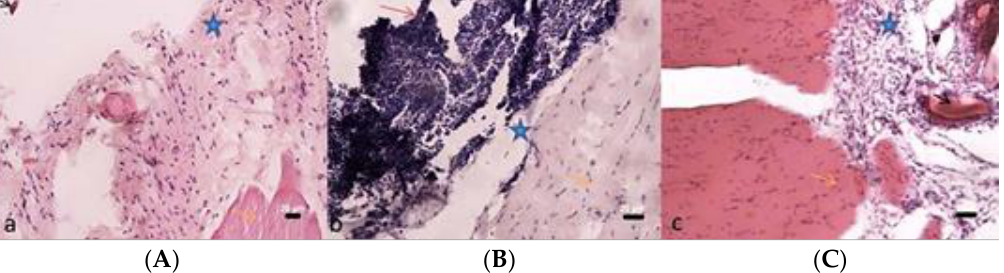
Figure 8. Hematoxylin and eosin-stained sections of the experimental site at the 30th day: ( A ) mouse with implanted hydrogel in the region of the hypodermis and the cutaneous panniculus carnosus muscle; ( B ) mouse with surgical sutures with polycon semi-elastic surgical thread of experimental muscle lacerations in the region of m. biceps femoris and m. semitendinosus; ( C ) mouse with implanted hydrogel in surgical lacerations in the region between m. biceps femoris and m. semitendinosus; Designations: implanted hydrogels (black arrows); fibrous capsule (blue 5-point stars); muscle fibers (orange short arrows); demarcation inflammation (red long arrow). Scale bar 20 µm .